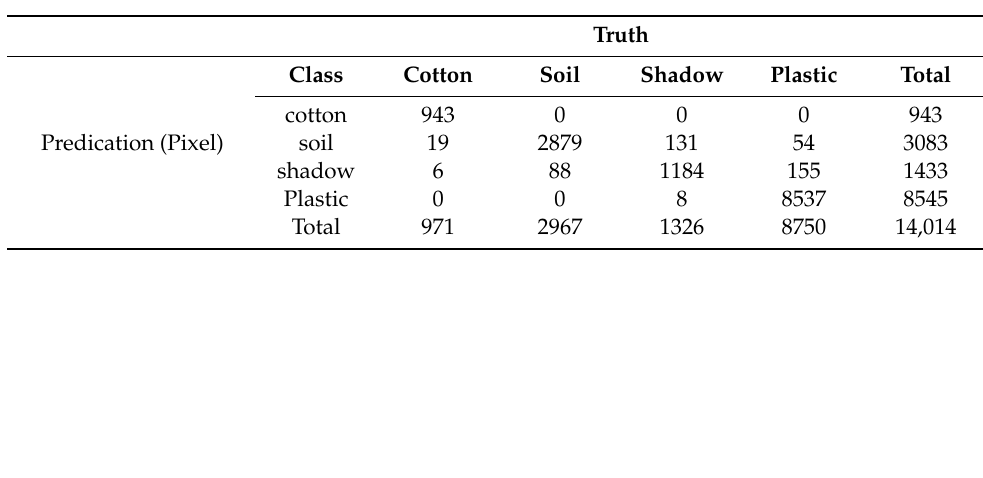
Table 1. Confusion Matrix of the classification